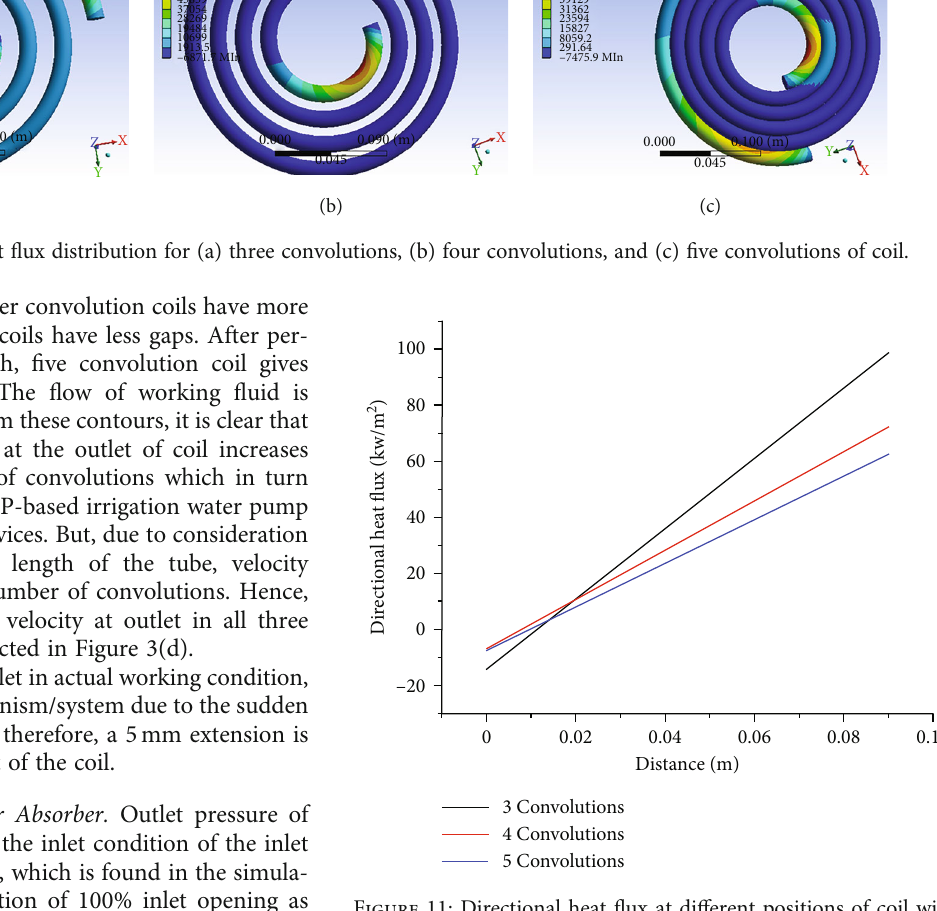
Figure 11: Directional heat fl ux at di ff erent positions of coil with varying number of